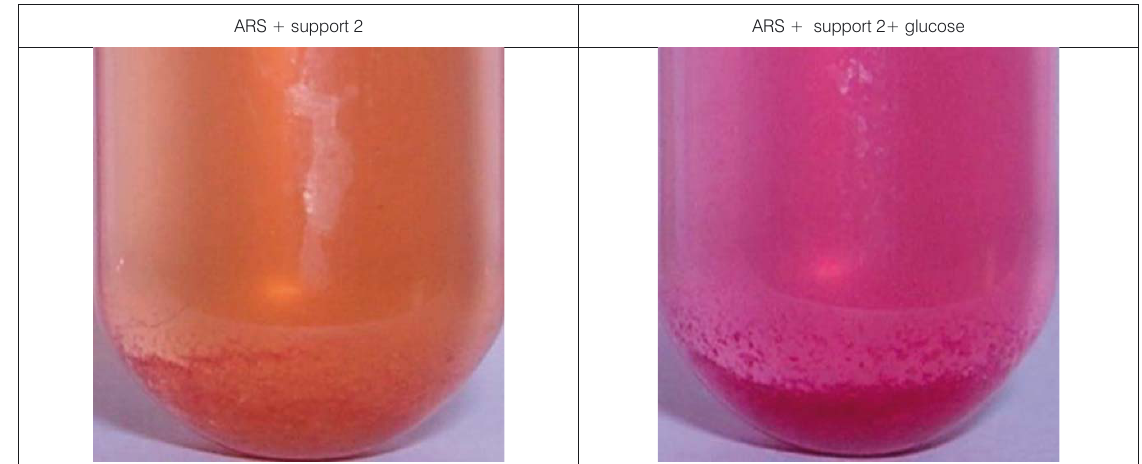
Figure 2. The influence of ARS and glucose solution on the color change of the support 2 from yellow to